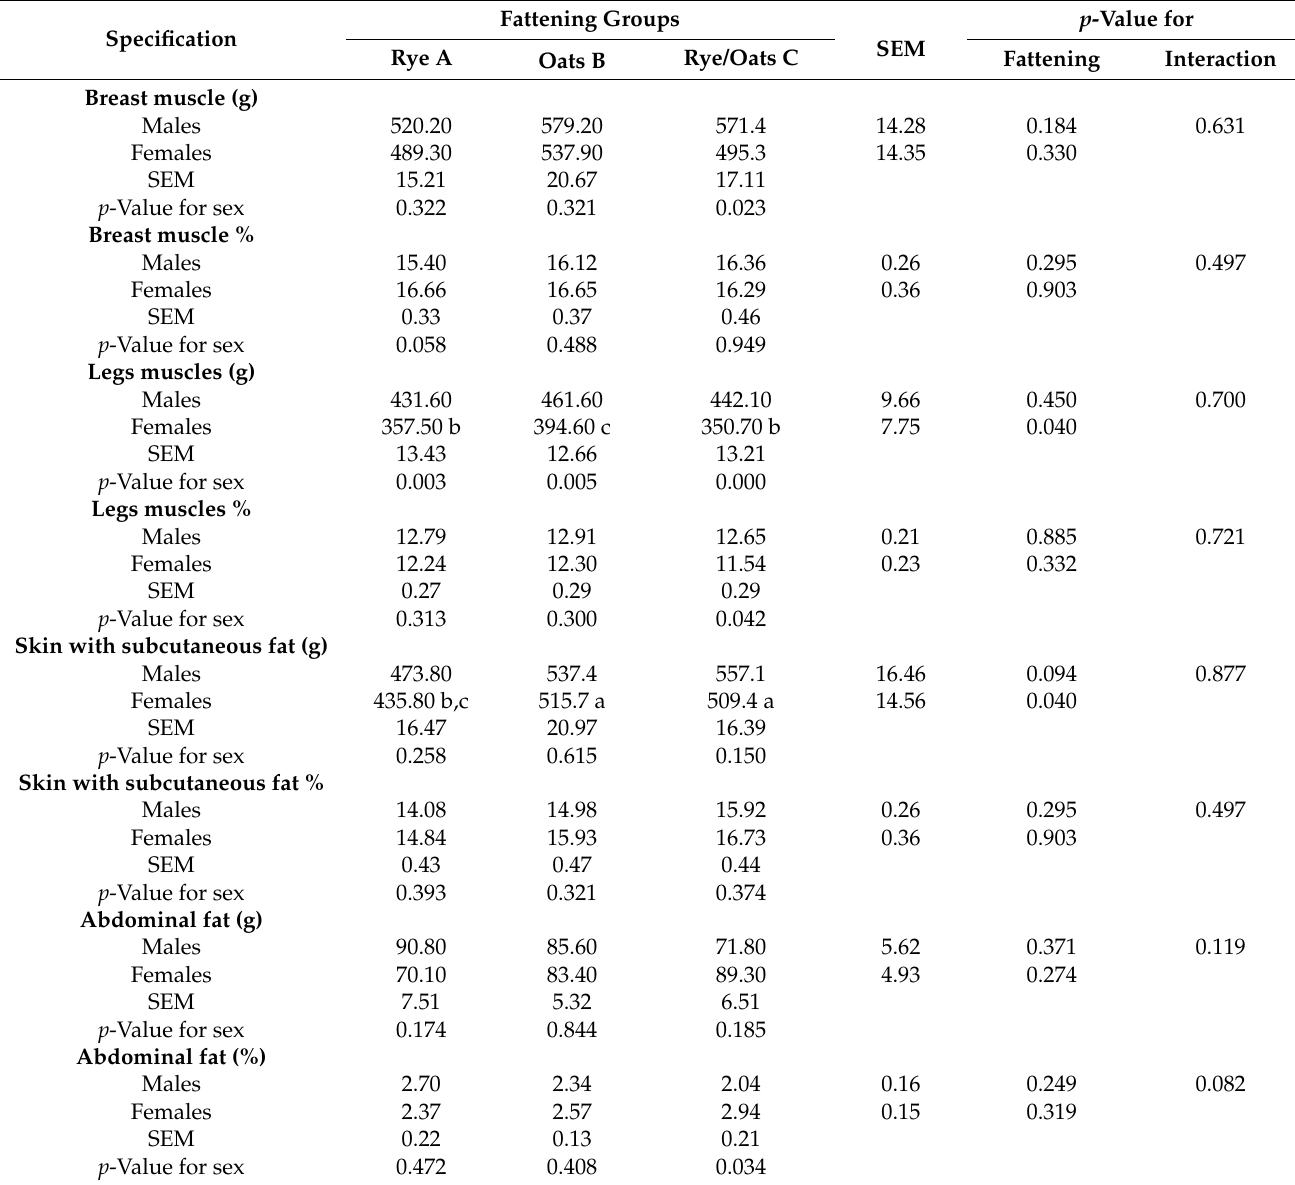
Table 5. Mean of weight and percentage of chosen muscles and fat obtained from the dissection of geese